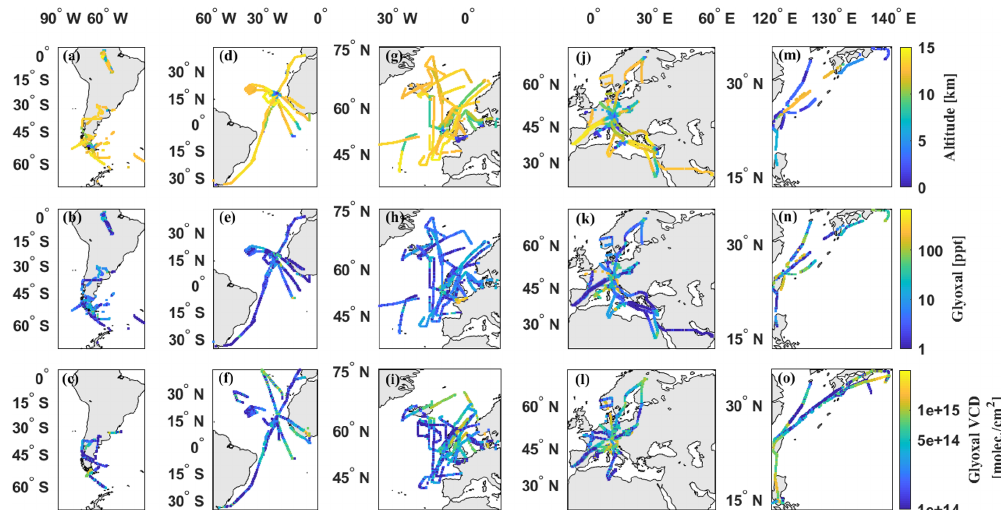
Figure 5. Flight trajectories, measured glyoxal mixing ratios, and VCDs are displayed in the top, middle, and bottom rows, respectively, over South America (a–c) , the tropical Atlantic (d–f) , the North Atlantic (g–i) , continental Europe (j–l) , and Southeast Asia (m–o) . Note the logarithmic colour scale in the two lower rows of the